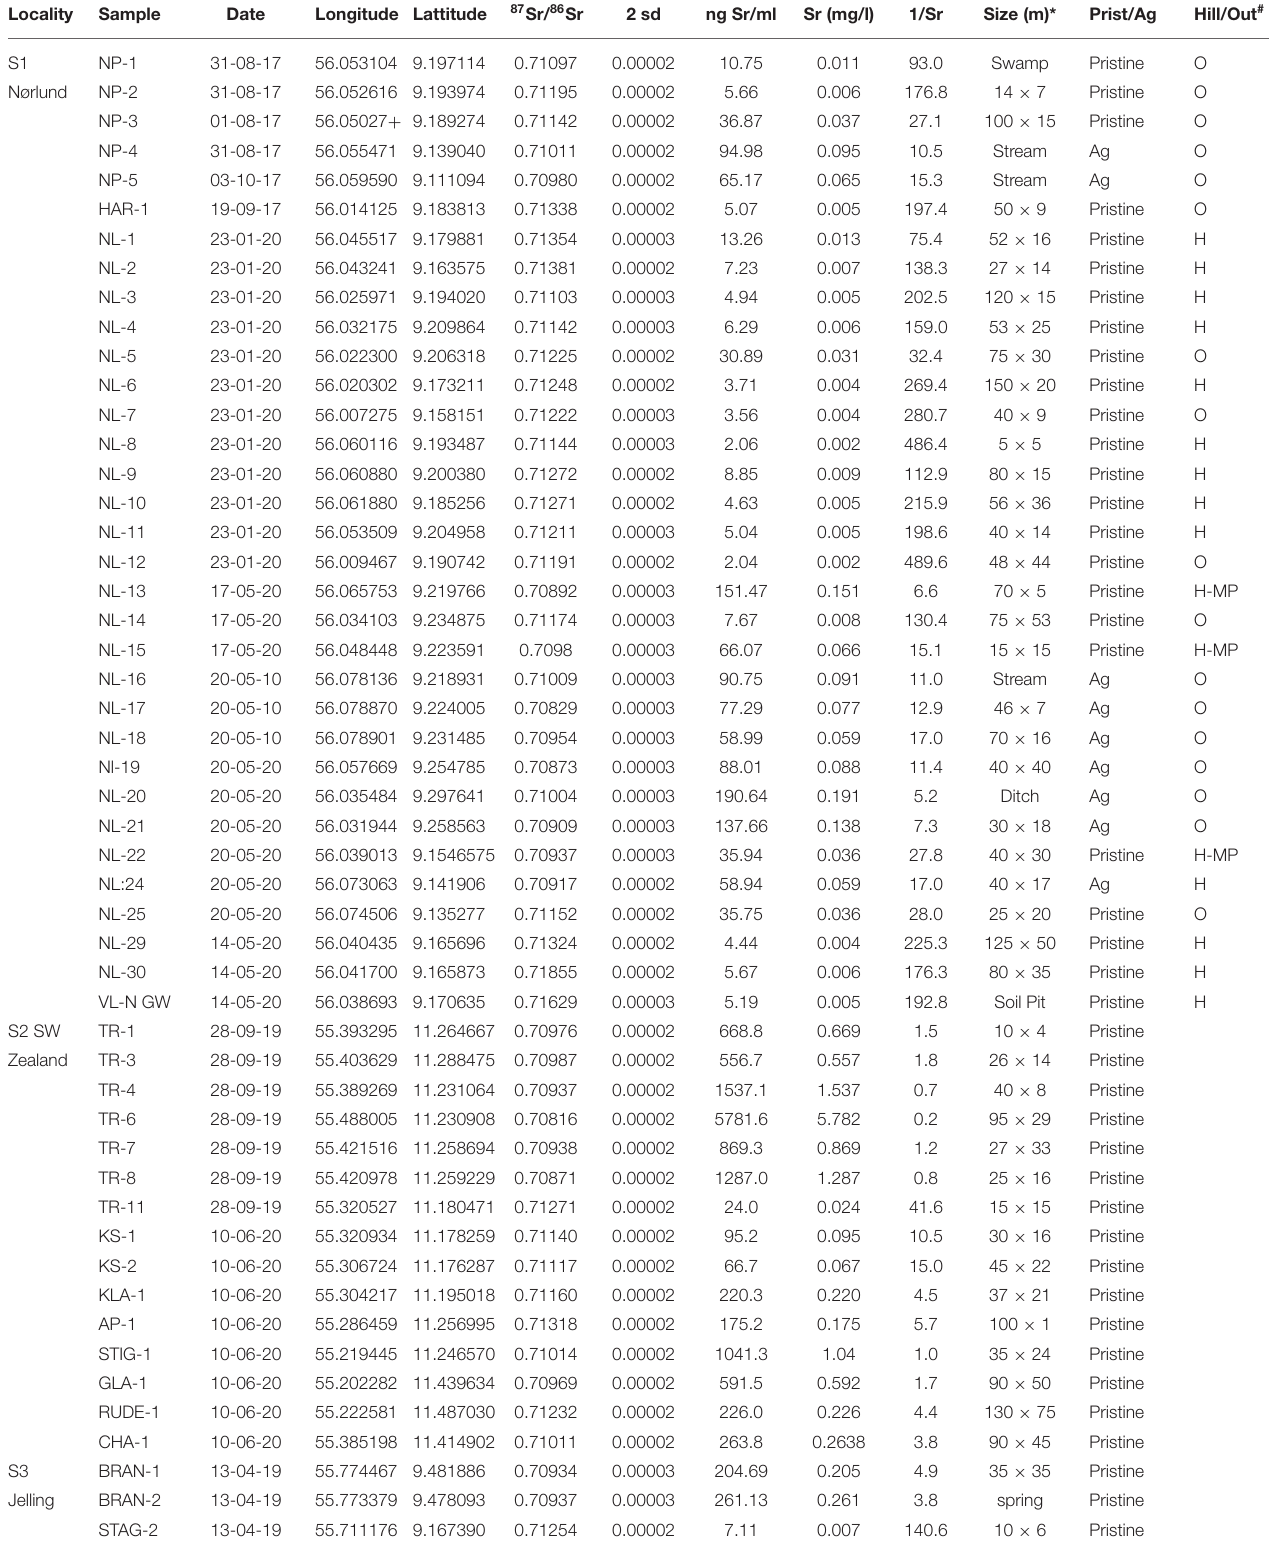
TABLE 1 | Strontium isotopic composition and concentration of surface water of investigated samples.